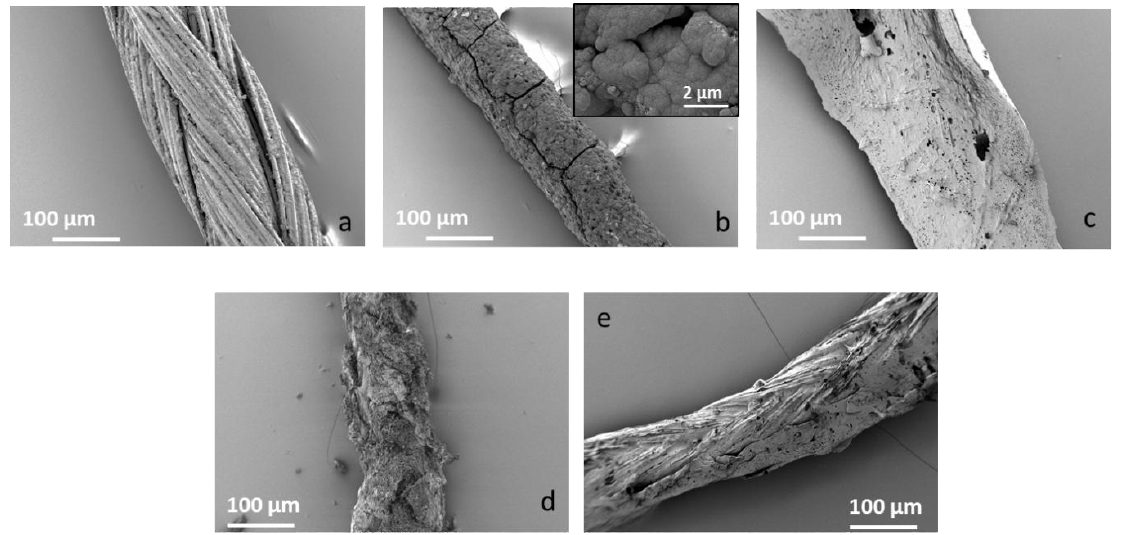
Figure 3. SEM micrographs of uncoated Vicryl ® Plus sutures. ( a ) Chitosan/Ag-MBG coated suture, ( b ) PCL/Ag-MBG-coated suture, ( c ) chitosan/Zn-BG suture, ( d ) PCL/Zn-BG suture, and ( e ) suture after 3 days of immersion in SBF: The chitosan/Ag-MBG-coated suture developed a layer, which can be ascribed to hydroxyl-carbonate-apatite based on its morphology.